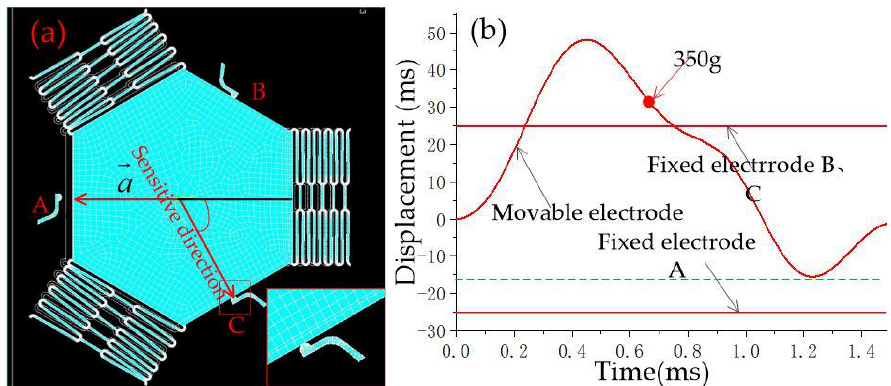
Figure 8. ( a ) Schematic diagram of a movable electrode in contact with a fixed electrode in the directions away from the sensitive direction of 45°, ( b ) the dynamic contact process curves of mov- able and fixed electrodes in the directions away from the sensitive direction of 45°.